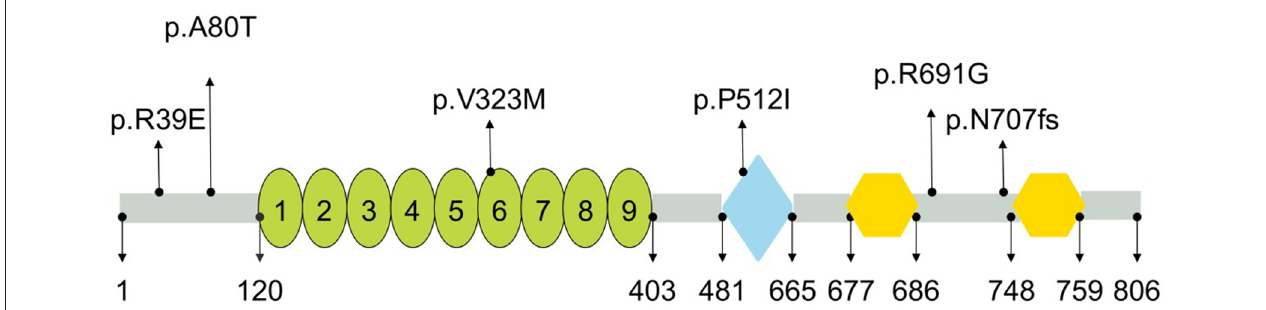
FIGURE 3 | Schematic representation of PLA2G6 and location of mutations identified in present study. PLA2G6 consisted of nine ankyrin repeats (oval), patatin-like phospholipase (diamond), and two binding sites for calmodulin (hexagon). Numbers shown below were the amino acid positions